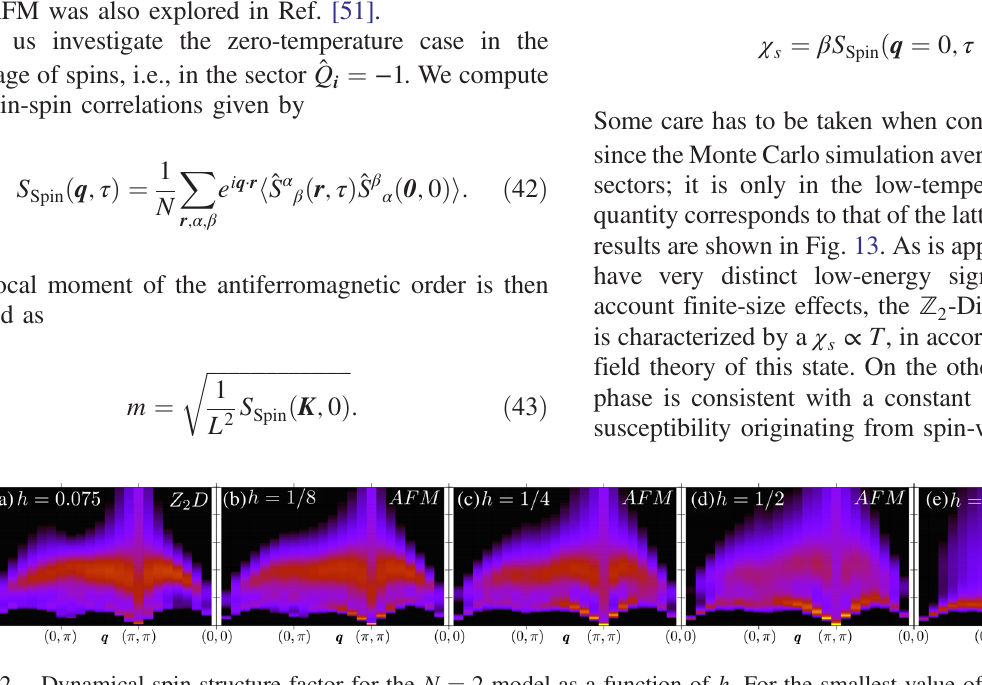
ˆ Q ≃ 1 . c such that i